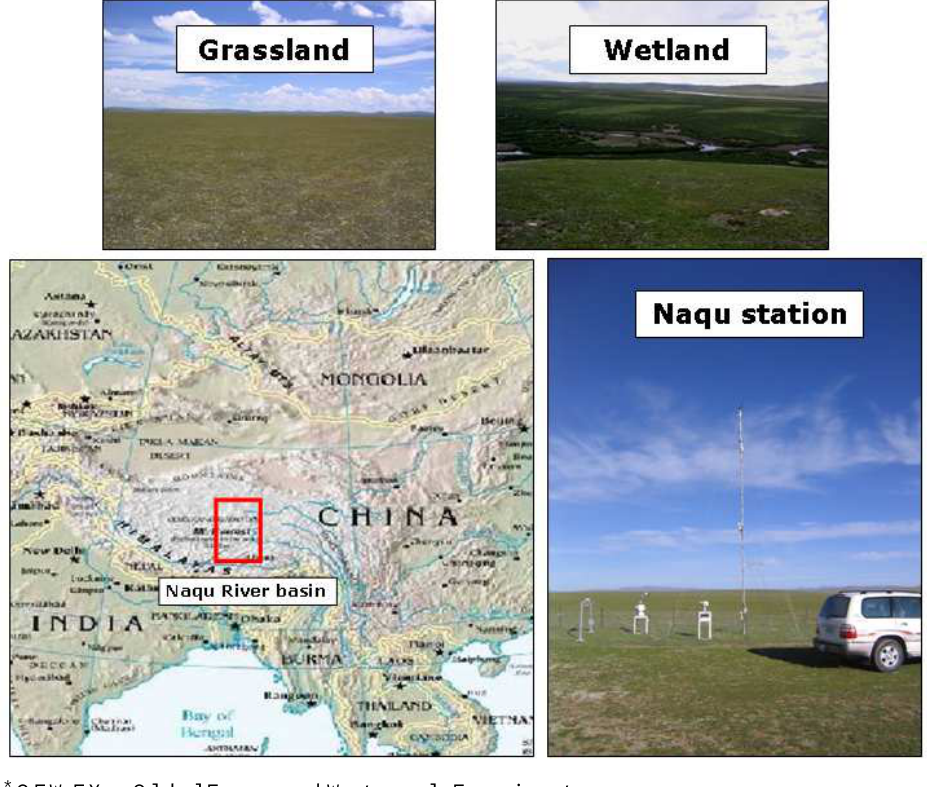
Figure 1. Geographical location of Naqu river basin and photos of Naqu station and a typical grassland and wetland in the study